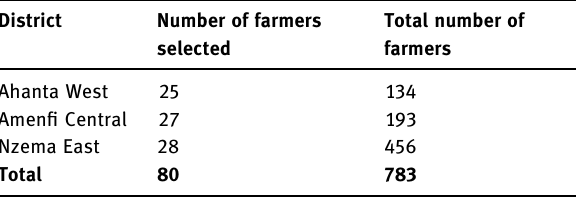
Table 1: Distribution of smallholder farmers across the three selected districts in the Western Region of Ghana